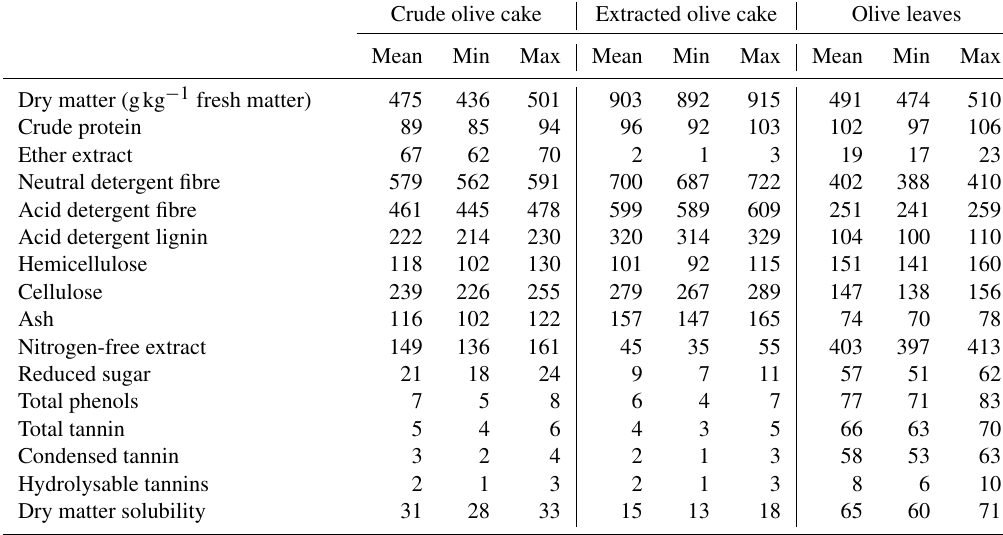
Table 1. Chemical composition (gkg − 1 dry matter). Crude olive cake Extracted olive cake Olive leaves